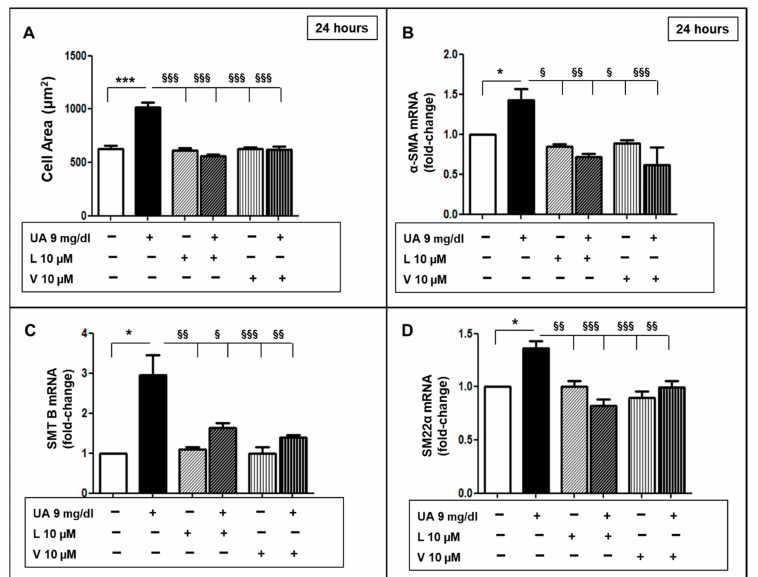
Figure 8. ARBs blunted UA-mediated VSMC phenotypic modification. ( A ) Both L and V (both 10 µ M) inhibited the cell area increase induced by UA. ( B – D ) L and V treatment protected VSMCs from α -SMA, SMTB and SM 22 α mRNA changes induced by UA. mRNA levels were measured by rt-PCR. Results represent means ± SEM obtained from three/four independent experiments and are expressed as fold change to CTR. * p < 0.05 and *** p < 0.0001 vs. CTR; § p < 0.05, §§ p < 0.01, §§§ p < 0.0001 vs. UA treated cells. ARBs = Angiotensin Receptor Blockers; VSMC = Vascular Smooth Muscle Cells; L = Losartan, V = Valsartan; UA = Uric Acid; α -SMA = α -Smooth muscle actin; SMT B = Smoothelin B; SM22 α = Smooth Muscle 22 α ; rt-PCR = real time PCR; CTR = control, untreated cells.